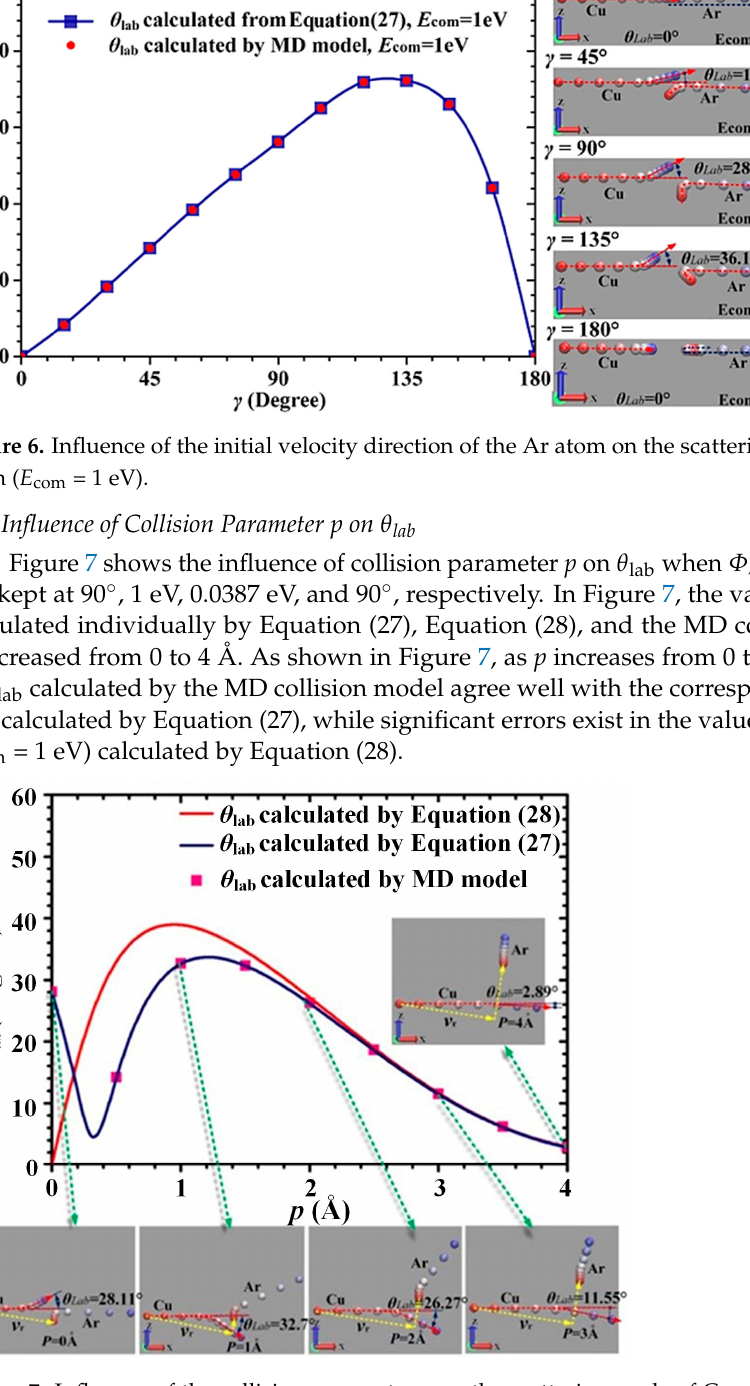
Figure 7. Influence of the collision parameter p on the scattering angle of Cu atom when Φ = 90° ( E com = 1eV).